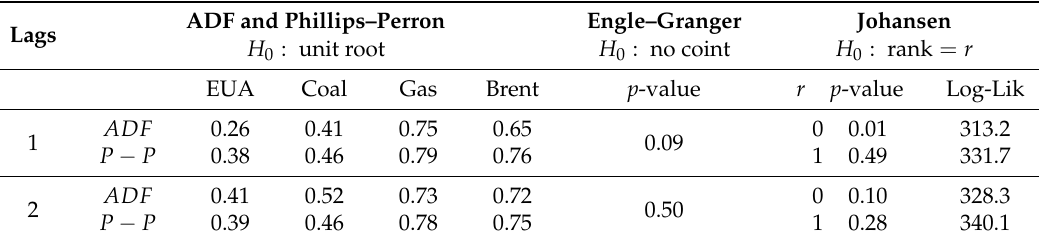
Table 7. (MacKinnon) p -values corresponding to Augmented Dickey–Fuller (ADF) and Phillips–Perron (P-P) unit root tests (left columns) and corresponding to Engle–Granger and Johansen cointegration tests (right columns) for the monthly forward series.